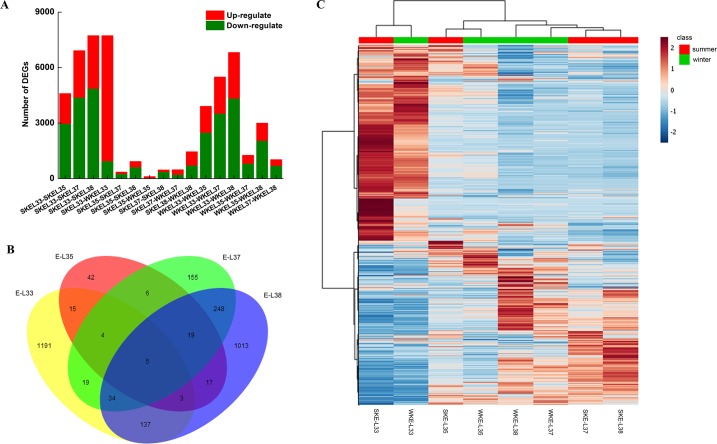
Differential gene expression in grapes under a two-crop-a-year cultivation system.(A) Numbers of DEGs in pairwise comparisons of eight samples. (B) Venn diagram showing DEG distributions. (C) Expression profile clustering.